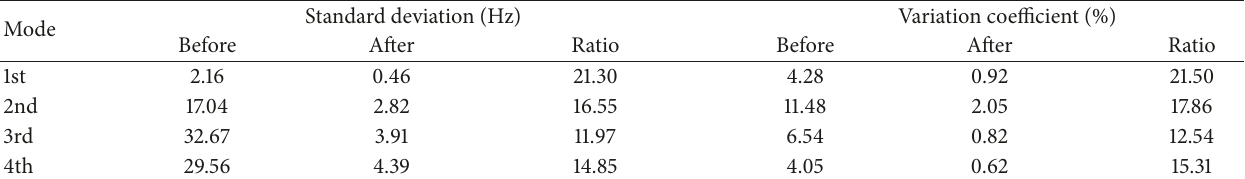
Table 4: Variability of first four modal frequencies before and after eliminating temperature effect.